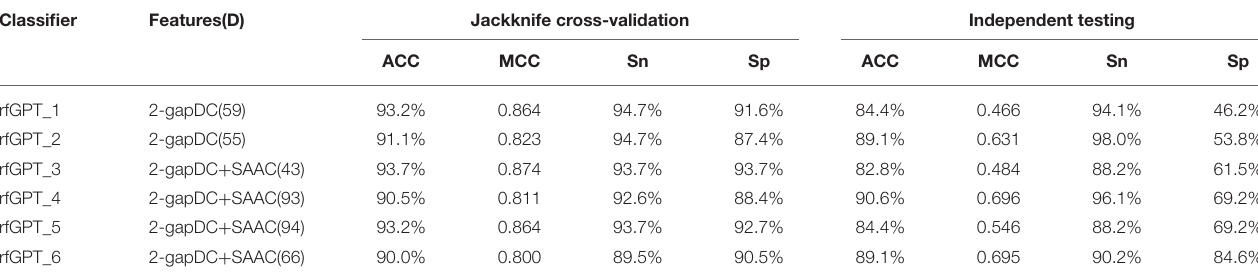
TABLE 2 | The best evaluation scores from jackknife cross-validation and independent testing of different models with various feature types and feature numbers.